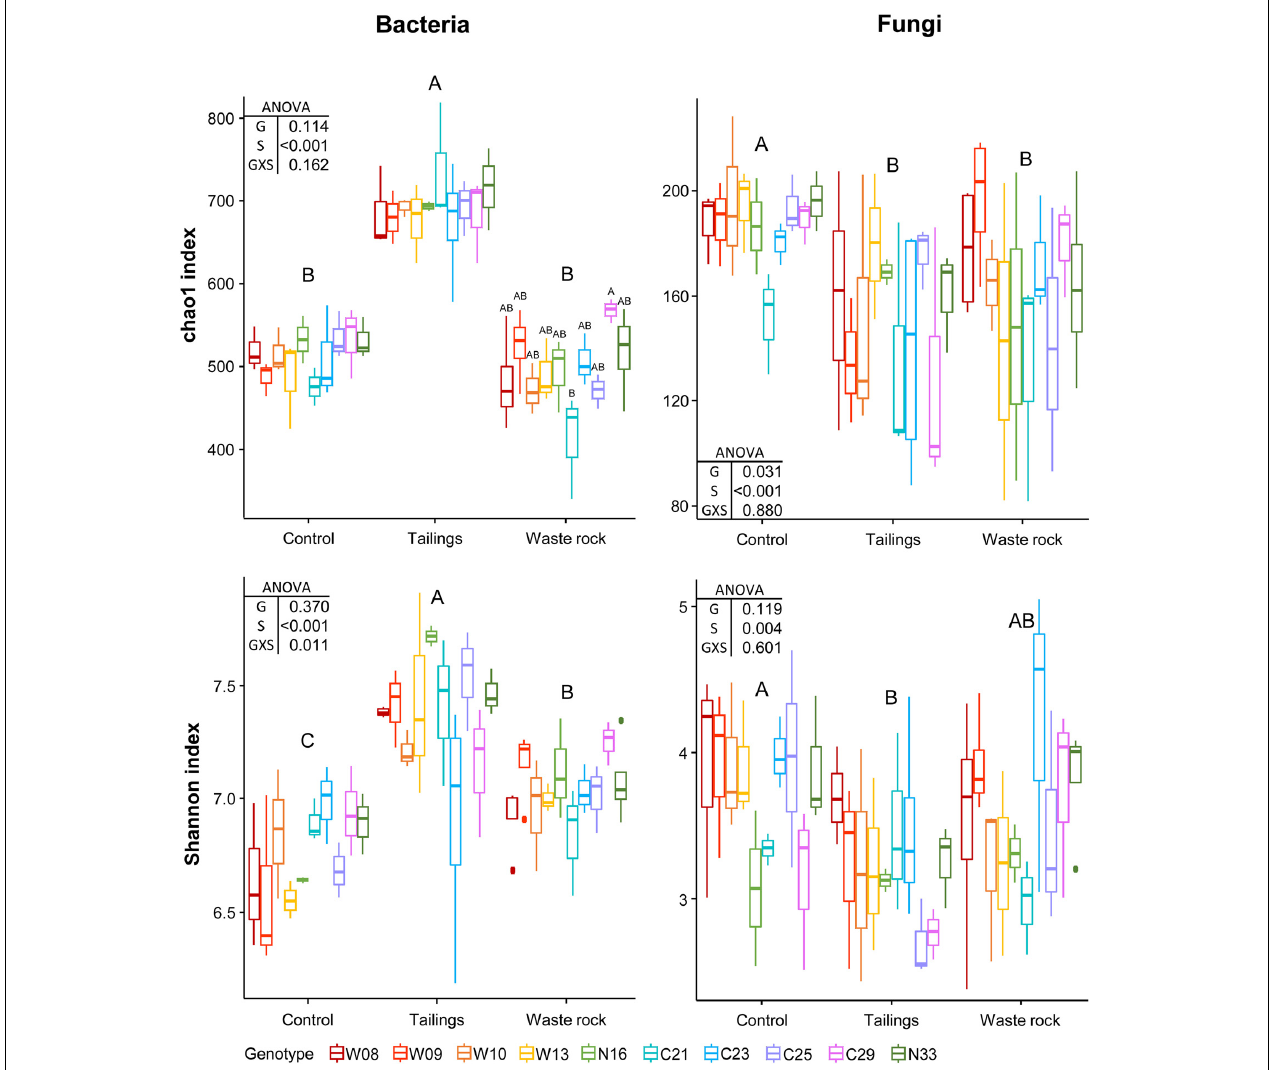
FIGURE 4 | Alpha diversity indices of bacterial and fungal community profiles in greenhouse samples. A two-way ANOVA was used to discern how genotype, substrate type and their interaction influenced alpha diversity indices. In the ANOVA table, G is genotype; S is substrate type; and GXS is the interaction between genotype and substrate type. Shared letters between treatments means there is no significant difference between these treatments, as determined by Tukey HSD post hoc pairwise comparison test ( n ≥ 3). Significance level is p < 0.05. Genotype had a significant effect on bacterial richness in waste rock only (chao1 index; p =